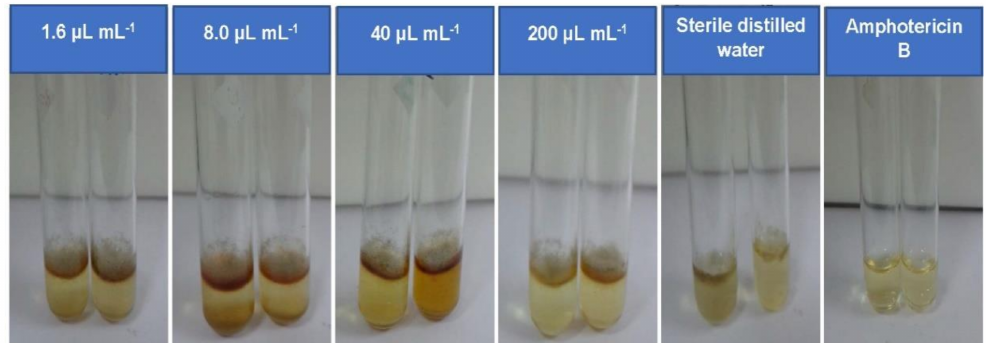
Figure 1. Example of broth macrodilution assay of aqueous extract from the grape-based compost at concentrations (from left to right) of 1.6 µ L mL − 1 , 8 µ L mL − 1 , 40 µ L mL − 1 , and 200 µ L mL − 1 , against 2 × 10 4 spores mL − 1 suspension of S. sclrerotiorum (isolate 18015) 7 days after inoculation, when compared with sterile distilled water (negative control) and Amphotericin B (positive